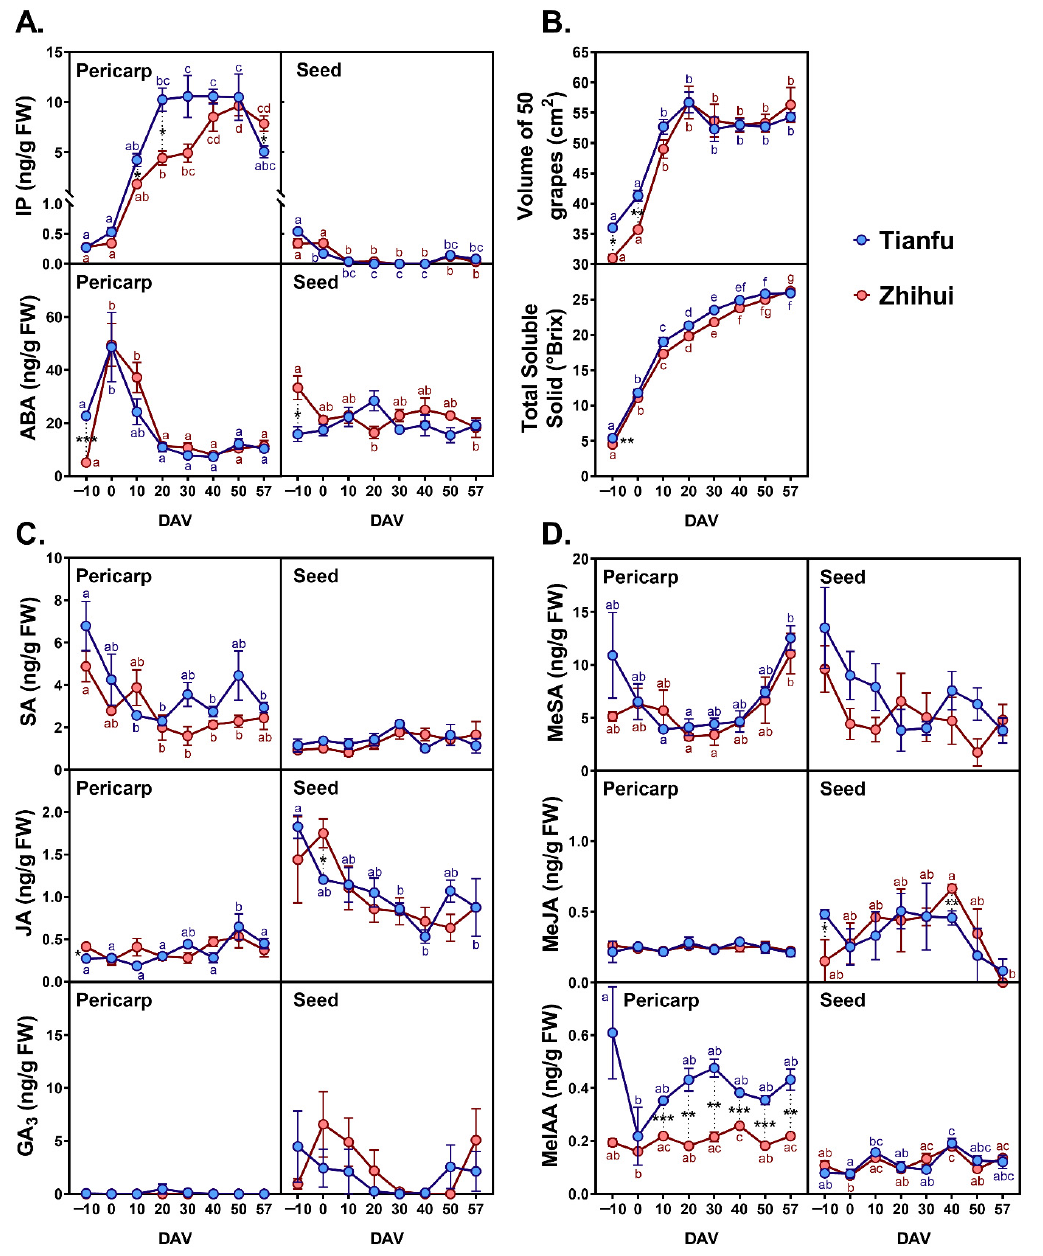
Figure 7. ( A , C , D ) The dynamics of IP, ABA, SA, JA, GA 3 , MeSA, MeJA and MeIAA content in the pericarp and seed of the Cabernet Sauvignon grapes in Tianfu and Zhihui vineyards. ( B ) The volume of 50 grapes and total soluble solids (TSS) content. Vertical bars indicate standard error of mean (SEM) of 3 biological replicates. Different letters indicate significant differences among developmental stages (Tukey’s test, p < 0.05), and no letters indicate no significant differences. The asterisk indicates a significant difference between the two vineyards (Student’s t test, *, **, *** indicate p < 0.05, 0.01,